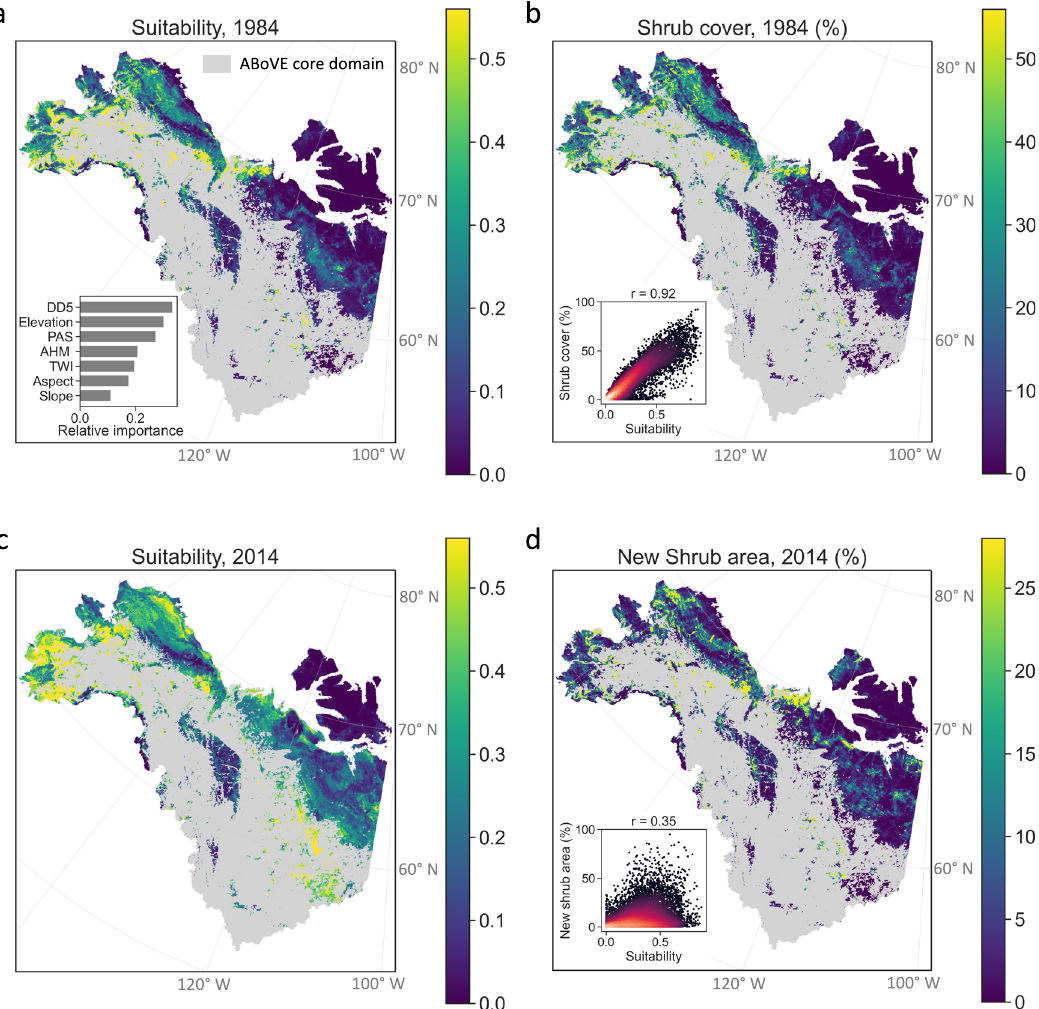
Fig. 1 Environmental suitability did not explain shrub expansion between 1984 and 2014. Environmental suitability of shrubs in ( a ) 1984 and ( c ) 2014 estimated using topographic and bioclimatic conditions, including annual degree-days above 5 °C (DD5), annual degree precipitation as snow (PAS), annual heat-moisture index (AHM), elevation, slope, aspect, and topographic wetness index (TWI). The inset of ( a ) shows the relative importance of these factors on environmental suitability. b Fraction of shrub cover in 1984. d Fraction of new shrub area at a 4 km scale in 2014, i.e., non-shrub tundra in 1984 that became dominated by shrubs by 2014. The insets of ( b , d ) show the corresponding relationships with environmental suitability, where brighter colors represent higher dot density. The gray areas are dominated by land-cover types other than shrubs and non-woody plants and are excluded from